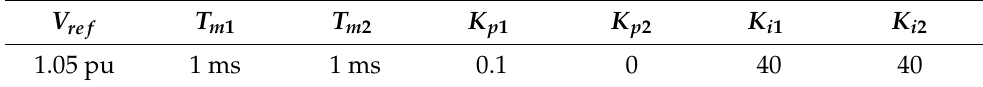
Table 4. Parameters of SVC voltage regulator considered in Section 3.2.